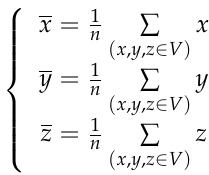
expressed by the centroids of those voxel grids to achieve down sampling. The coordinates (XYZ) of centroids can be calculated as follows: